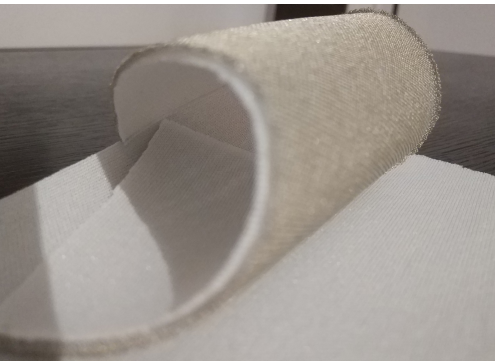
Figure 2. Continuous Substrate Integrating the Ground Plane-3D Weft knitted spacer fabric (white) with an integrated conductive layer